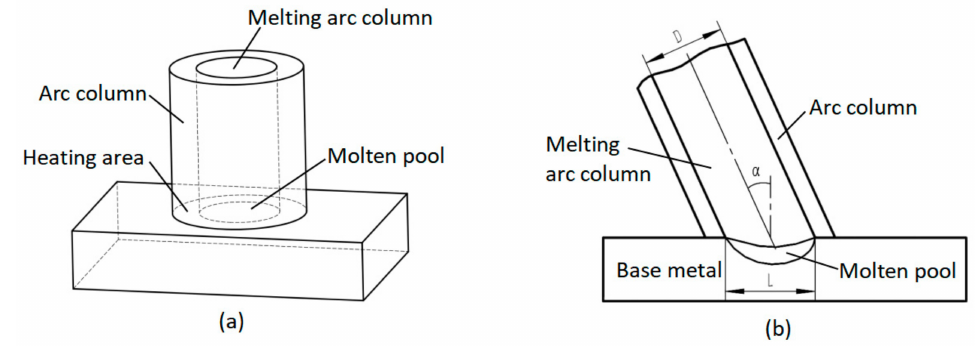
Figure 7. ( a ) Schematic diagram of melting arc column in arc and ( b ) schematic diagram of weld pool size after arc